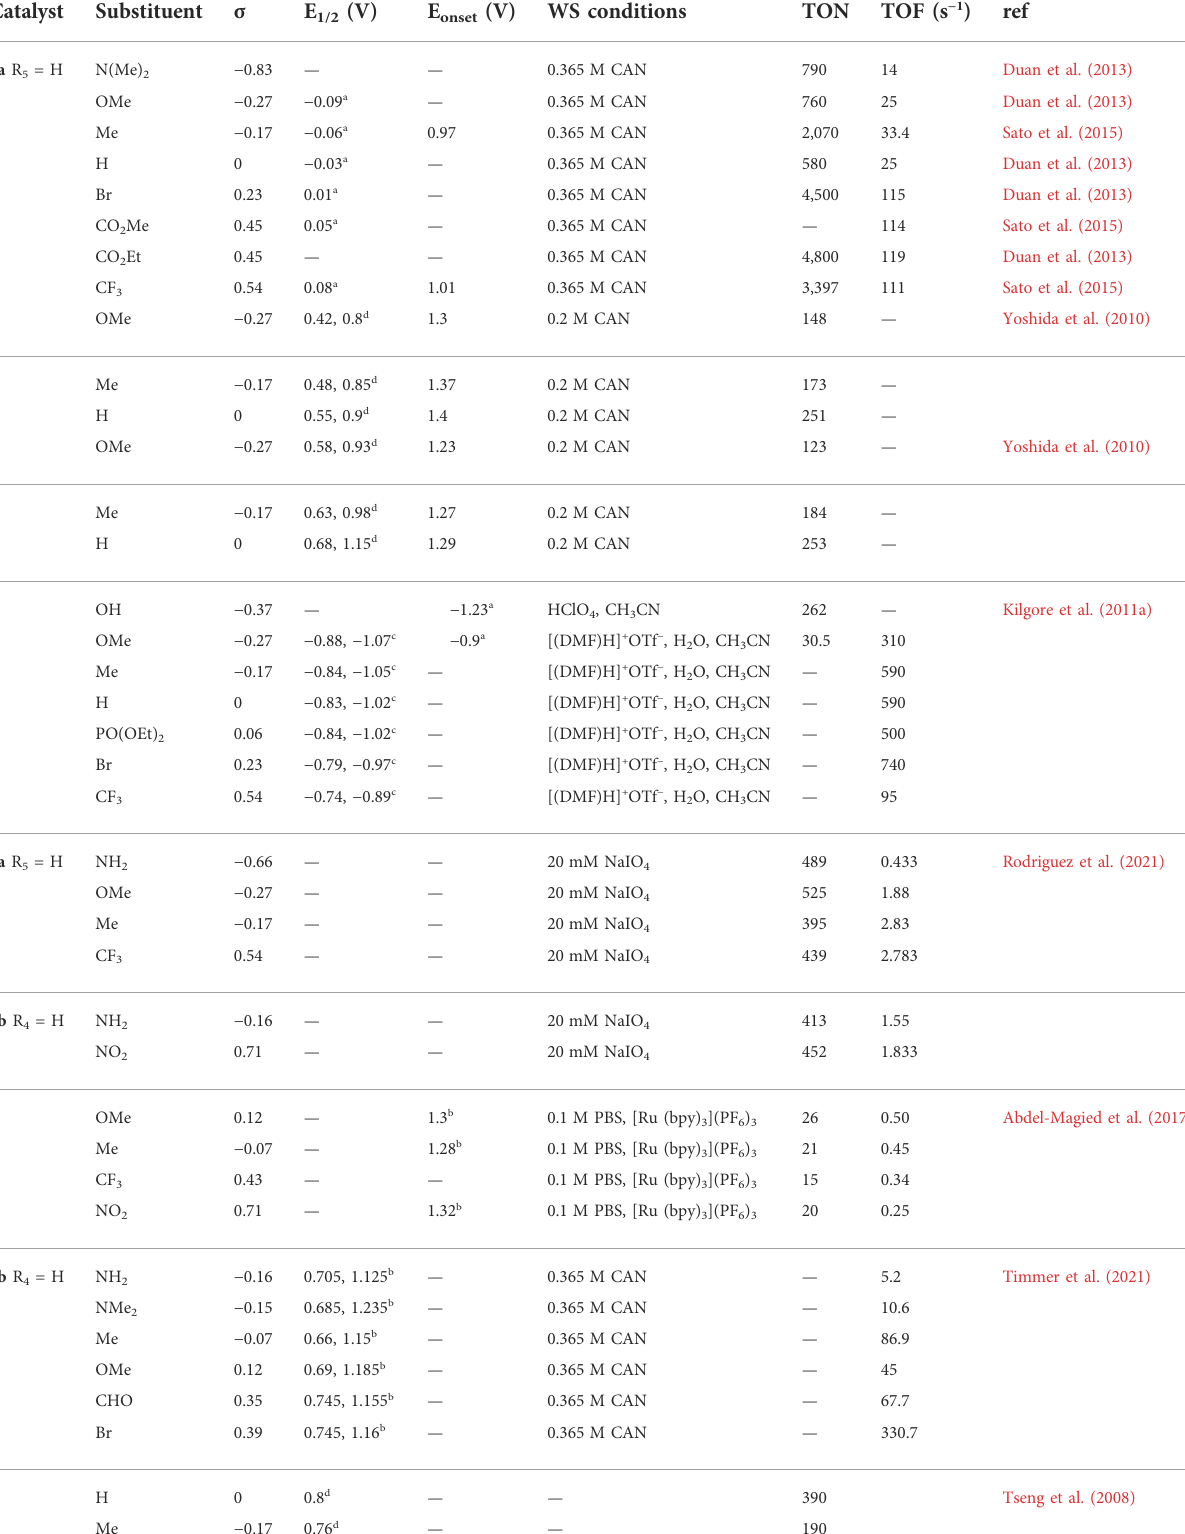
TABLE 1 Properties of metal complexes with different electron-donating/-withdrawing substituents. σ Data from ref (Hansch et al., 1991).